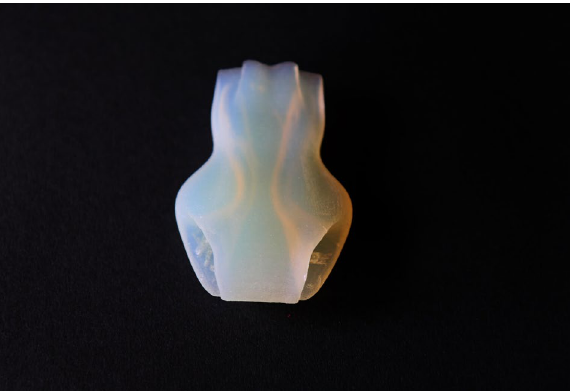
Figure 8 | Nose project Radiator / resonator – photo of 3D printed object in Flexible material Tango Plus 9740. Technology polyjet, solidified liquid photopolymer by using UV light (front view).